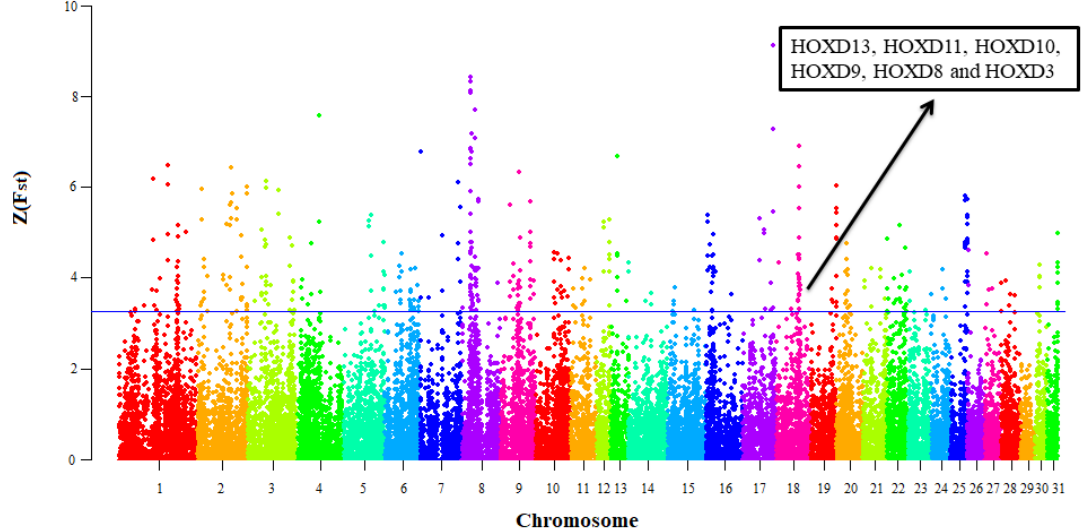
Figure 5. The distribution of absolute Z(F st ) values in 31 horse autosomes. The data points above the horizontal line (blue line, Z(F st ) ≥ 3.26) are top 1% Z(F st ) values. The HOXDs located on ECA18: 54.55–54.65Mb were overrepresented genes in top 1% log 2 (